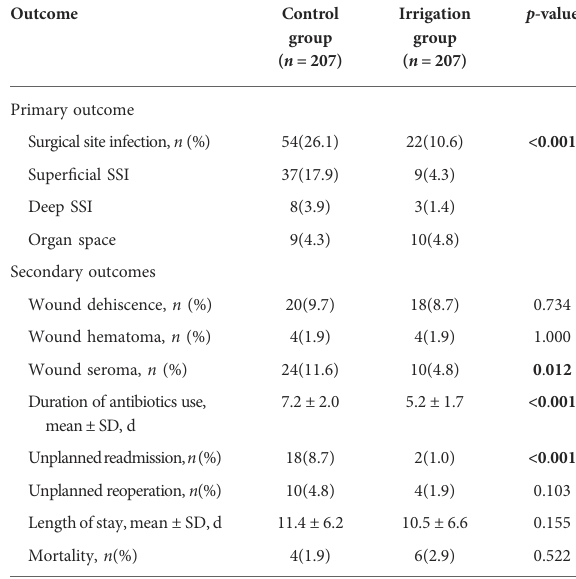
TABLE 1 Baseline characteristics after propensity score matching. TABLE 2 Postoperative outcomes within 30